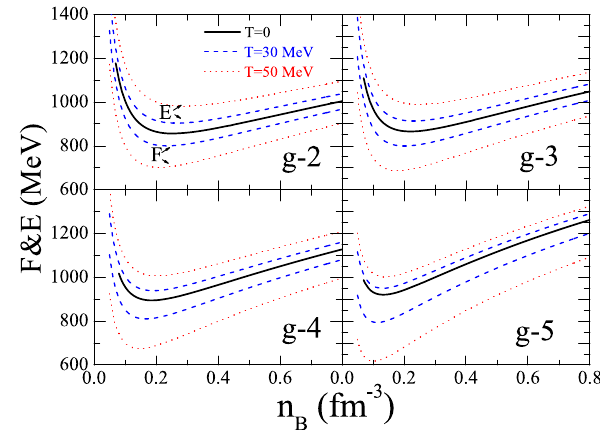
Fig. 1 Freeenergyperbaryonandenergyperbaryonasfunctionsofthe baryon density for SQM within the quasiparticle model with different parameter sets at finite temperature